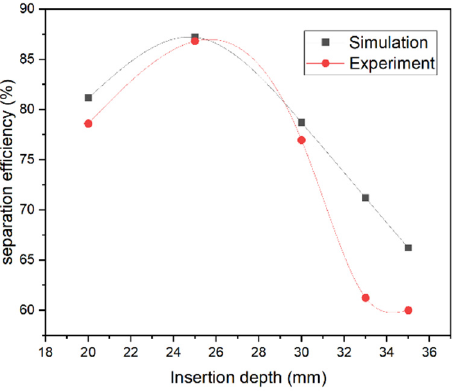
Figure 13. Concentration distribution of mini-hydrocycloness with different vortex finder depth